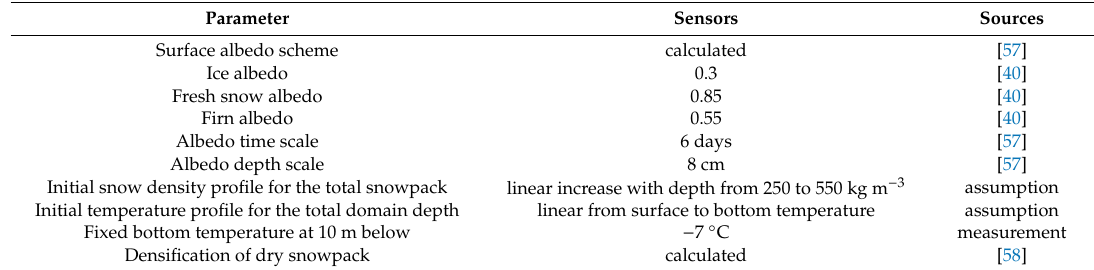
Figure 2. Daily mean values of ( a ) air temperature, ( b ) relative humidity, ( c ) wind speed, ( d ) air pressure, ( e ) cloud cover, and daily total precipitation ( f ) of AWS1 on the east branch of UG1 during the ablation period from 29 April to 1 September 2018. 4.2. Energy Balance at the Site of the AWS1 Table 3 and Figure 3 show the monthly and daily surface energy balance components in the ablation season, respectively. Net shortwave radiation ( SW net ) (84%) and sensible heat flux (16%)